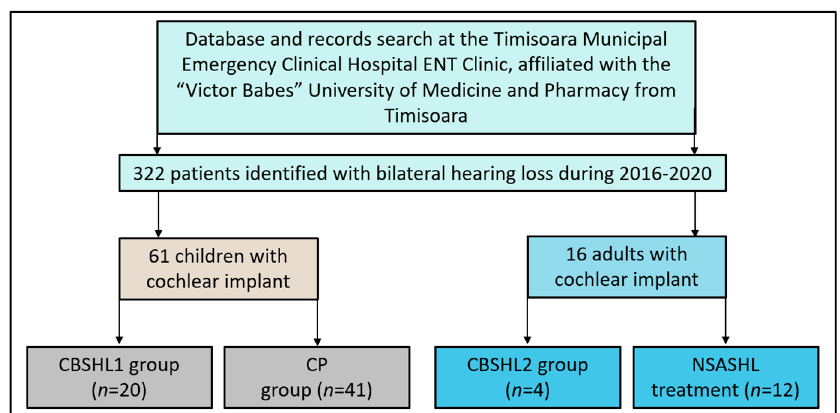
Figure 1. Study flowchart; CBSHL1—patients with congenital bilateral sensorineural hearing loss receiving their first implant; NSASHL—patients with non-congenital severe acquired bilateral sen- sorineural hearing loss; CBSHL2—patients with congenital bilateral sensorineural hearing loss; CP—previously implanted patients who were hospitalized for the change of processor (control group).